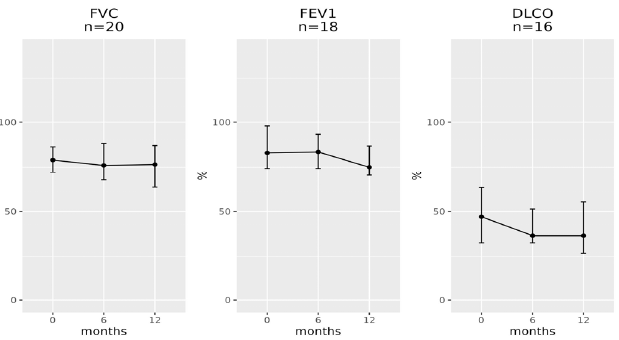
Figure 3. Trend for spirometry measurements between 0 and 12 months. Dots represent the median value, bars indicate the first (Q1) and the third (Q3) quartiles.